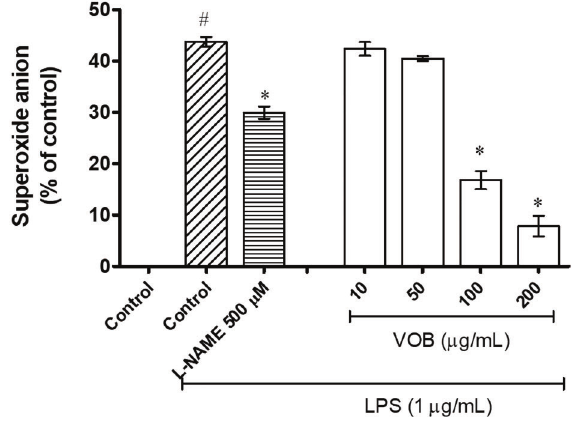
Figure 4. Inhibitory effects of vegetable oil blend (VOB) on intracellular superoxide anion production in lipopolysaccharide (LPS)-activated RAW 264.7 cells using the colorimetric NBT assay. Gallic acid (GA) was used as positive control. The level of superoxide anion in control cells was arbitrarily reported as zero. Data are reported as means ± SE of triplicate experiments. *P o 0.05 compared with LPS-treated cells. # P o 0.05 compared with control (ANOVA and the Tukey ’ s post-hoc Figure 4, O 2 – production induced by LPS decreased signi fi cantly (P o 0.05) after 100 and 200 m g/mL VOB was